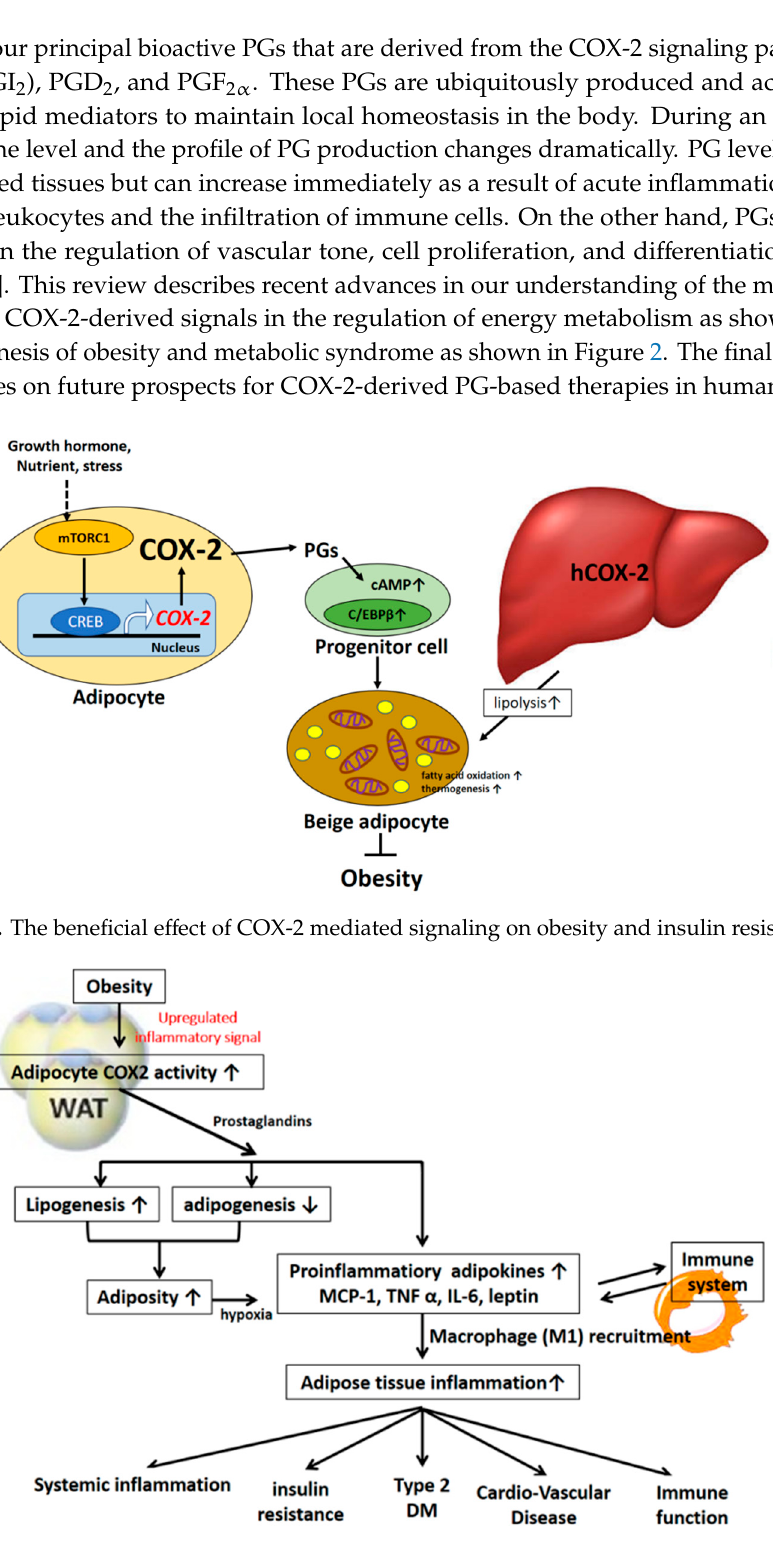
Figure 2. The detrimental effect of COX-2 mediated signaling on obesity and insulin resistance.